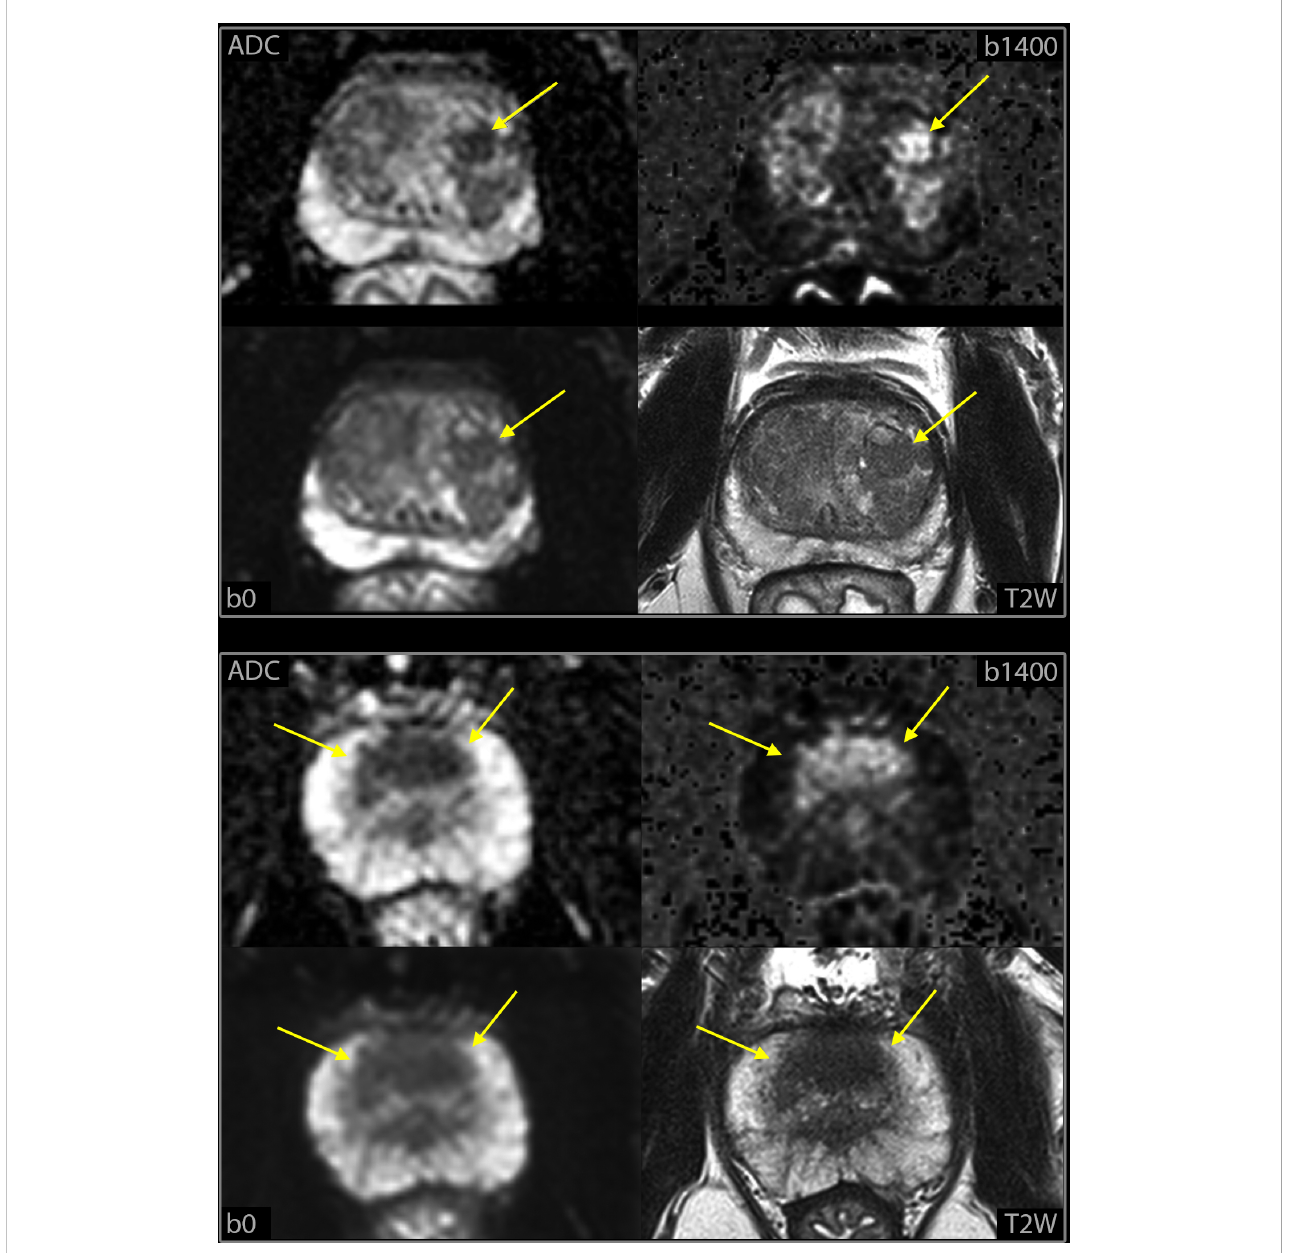
FIGURE 3 Example of fi ndings in the transitional zone at high-resolution DWI-only, Highly cellular lesions (yellow arrows), at calculated b1400 images and ADC maps, were interpreted as hyperplastic nodules and categorized as negative if round and centrally located at b0 (upper panel) but categorized as positive if crescent shaped and anteriorly located (lower panel). T2W images from mpMRI are included to illustrate the similarity in the morphologic appearance with the b0 DWI